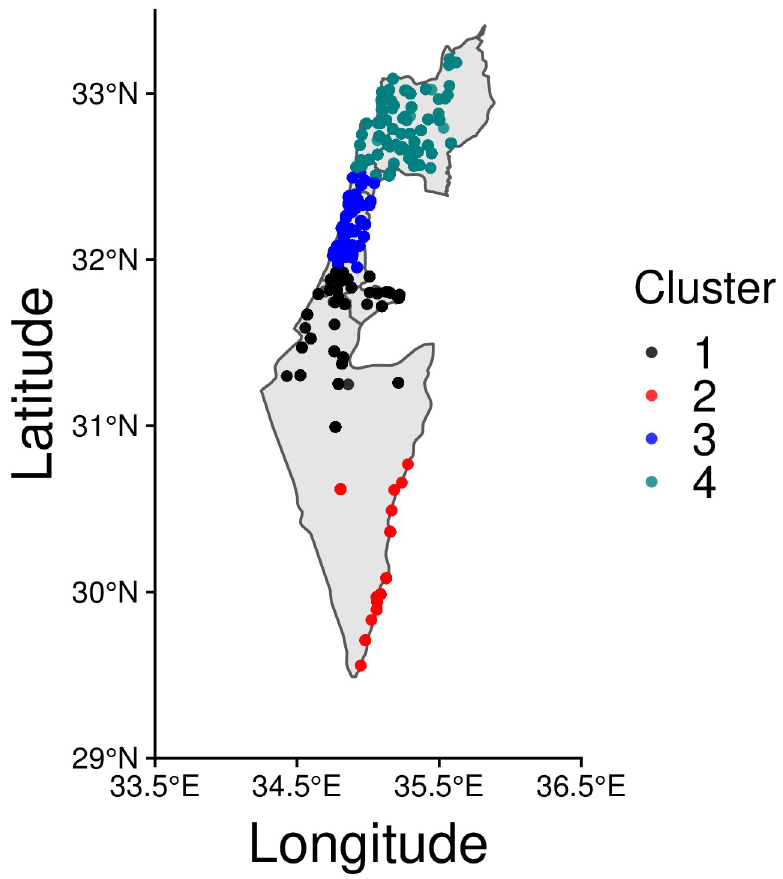
Fig 7. COVID-19 disorder events in Israel. Clusters C1, C3, C4 host the most densely populated areas located around the cities of Haifa, Tel Aviv and Jerusalem, respectively, Events in cluster C2, the least dense region, are the most sparse and emerge mostly at the border with Jordan. This map has been generated via rnaturalearth in R, a package built using Natural Earth map